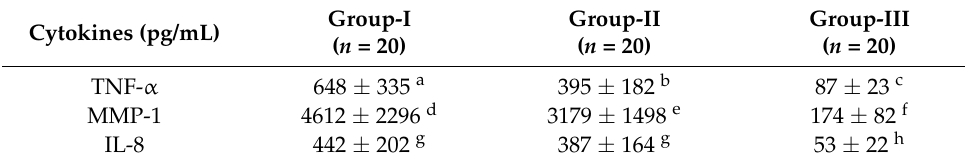
Table 3. Peri-implant crevicular fluid cytokine levels of the study